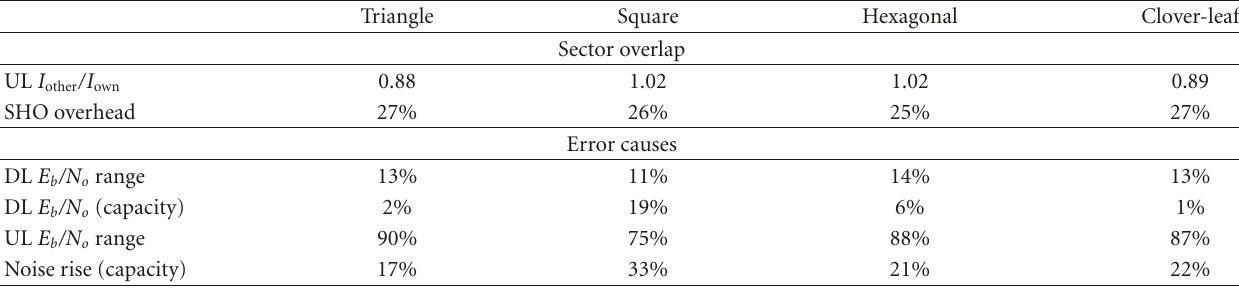
Table 5: System performance at optimum point.